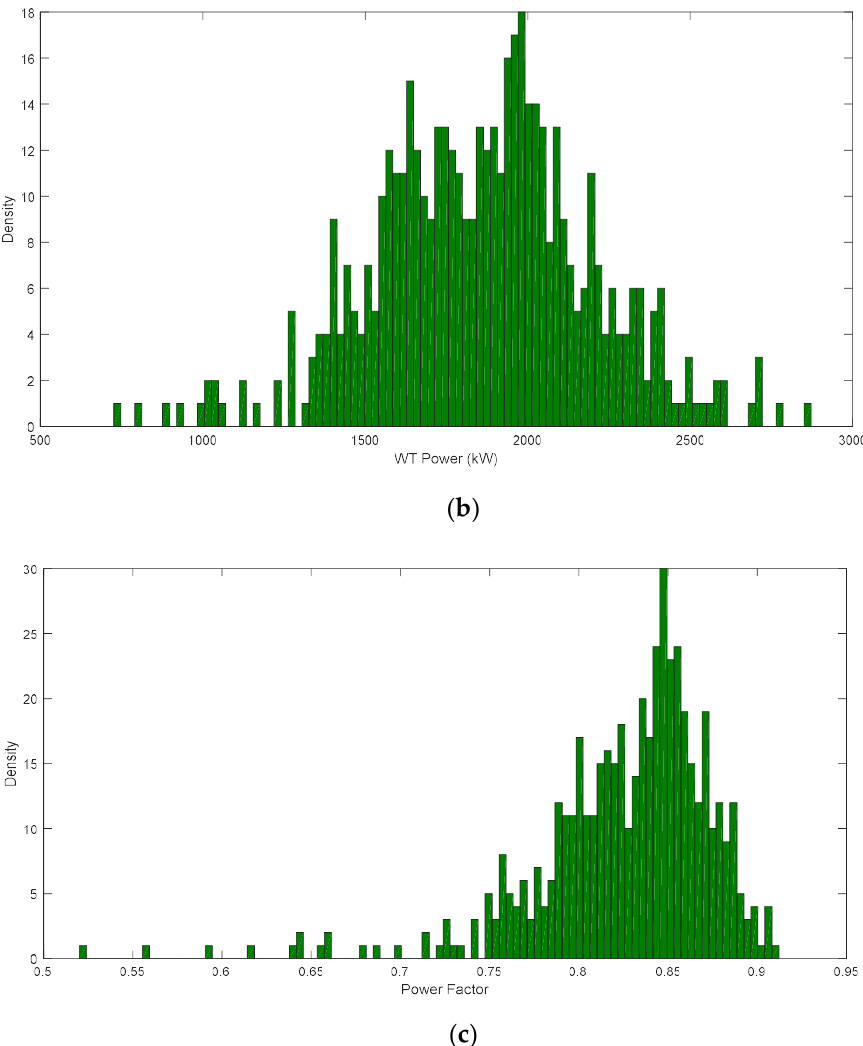
Figure 7. PDF of decision variables ( a ) installation location ( b ) capacity and ( c ) power factor.